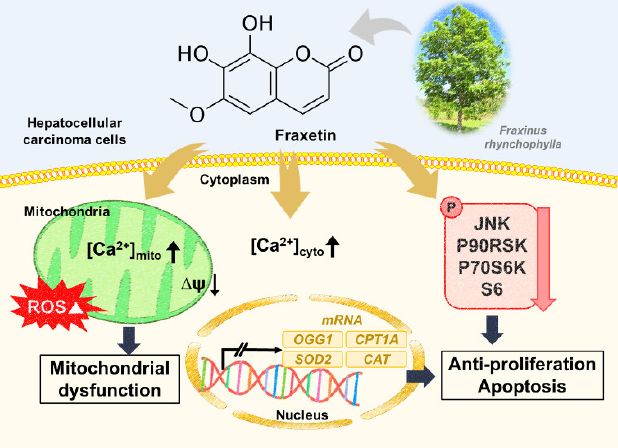
Figure 9. Schematic illustration of fraxetin in HCC cells.